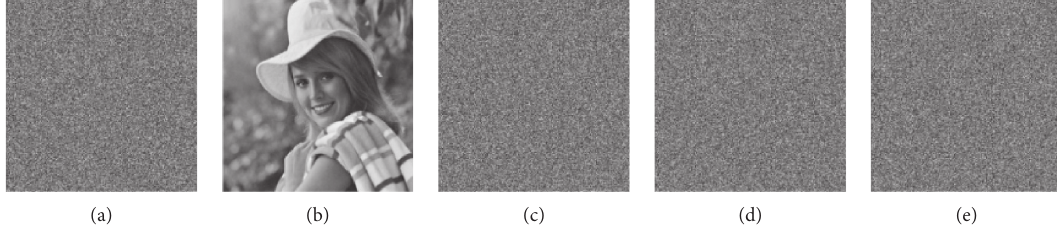
( 1 ) ˇC and ˇC R ; (f) difference image between R